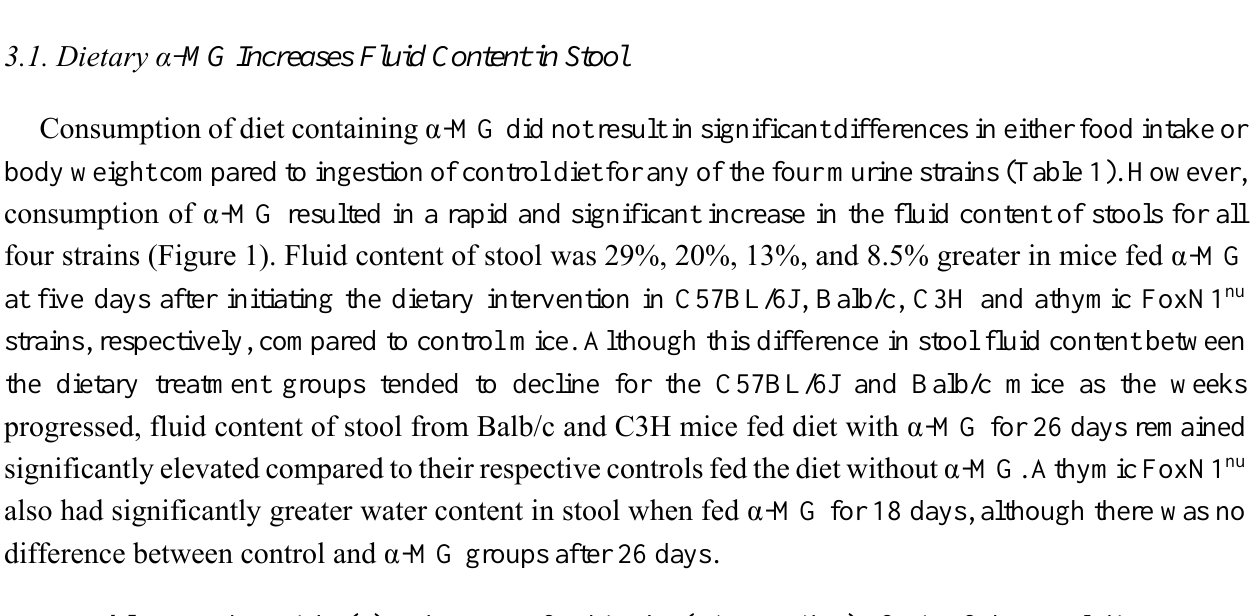
Table 1. Body weight (g) and average food intake (g/mouse/day) of mice fed control diet or diet with α-MG for 4